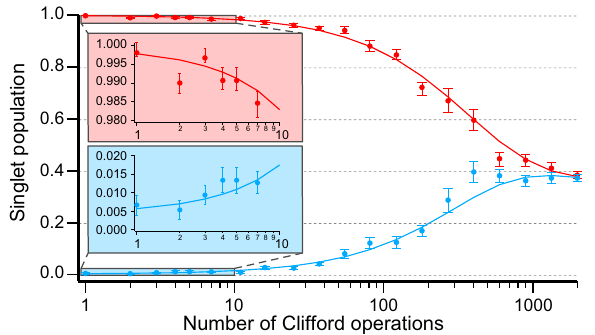
FIG. 7. The measurement of joint initialization and measure- ment fidelity from benchmarking contrast. The return-to-singlet (red) and return-to-triplet (blue) data points (with empirical error bars) are from blind randomized benchmarking. The solid curves are the corresponding error-bar-weighted fits to the functions given in Eq. (F1). The contrast of these curves, extrapolated to zero Clifford operations, indicates 1 − F BC = 2.5 ( 5 ) × 10 − 3 , with a per-Clifford qubit error of 1.7 ( 2 ) × 10 − 3 and a per-Clifford leak- age rate of 3.3 ( 9 ) × 10 − 4 . The upper and lower insets showing enlargements of the first ten points are provided only to empha- size full contrast at the shortest sequences; our extrapolation utilizes the full data set.